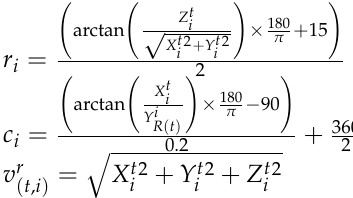
( b ) Figure 6. Results of point cloud clustering: ( a ) Raw point cloud; ( b ) the point cloud after clustering. Then, the clustered point cloud planar features are divided again into 6 regions equally according to the LiDAR horizontal scanning angle (0 ∼ 360°), and the same row